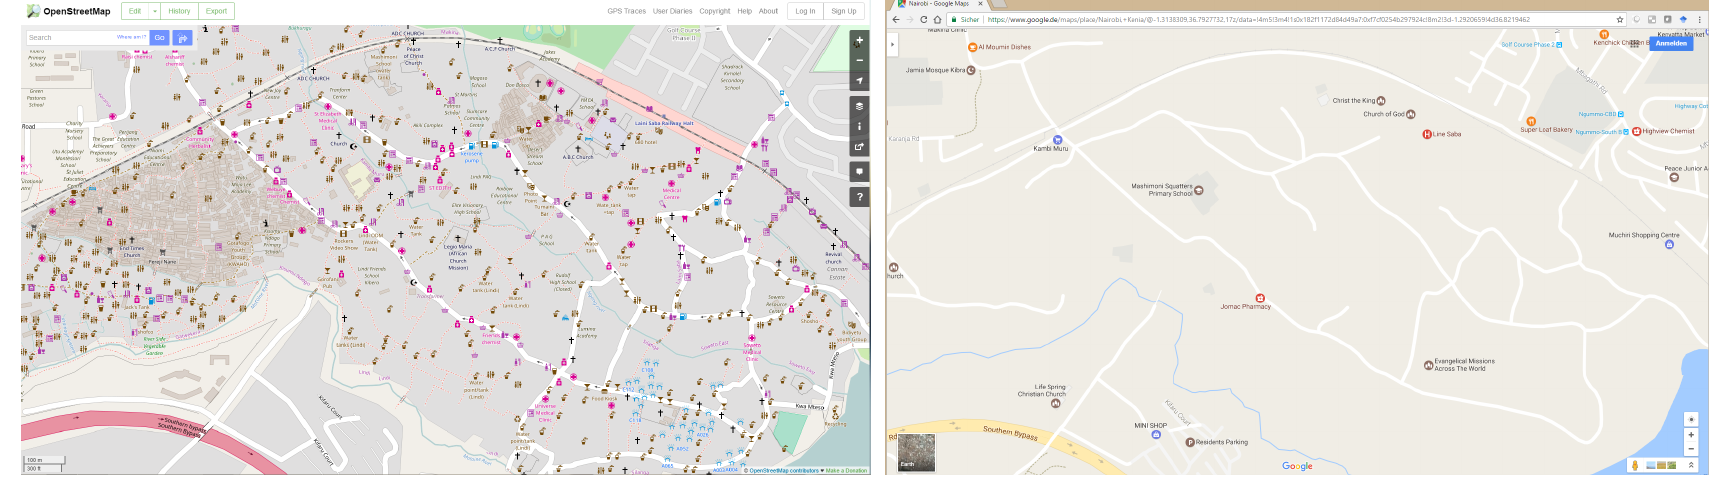
Figure 3. Map of Kibera, Nairobi, from OpenStreetMap (right) compared to Google Maps